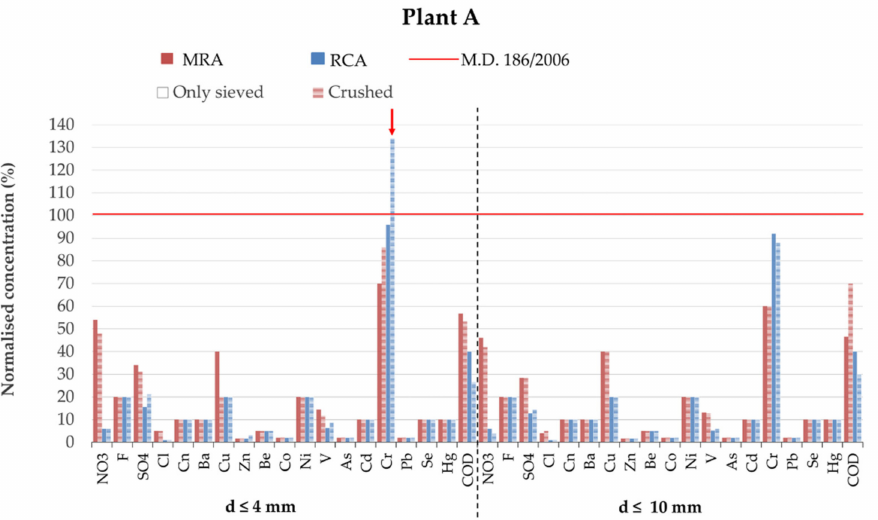
Figure 10. Plant A: trend of pollutant concentrations in relation to the type of RA (RCA or MRA), particle sizes, and test conditions (i.e., material only sieved or crushed).